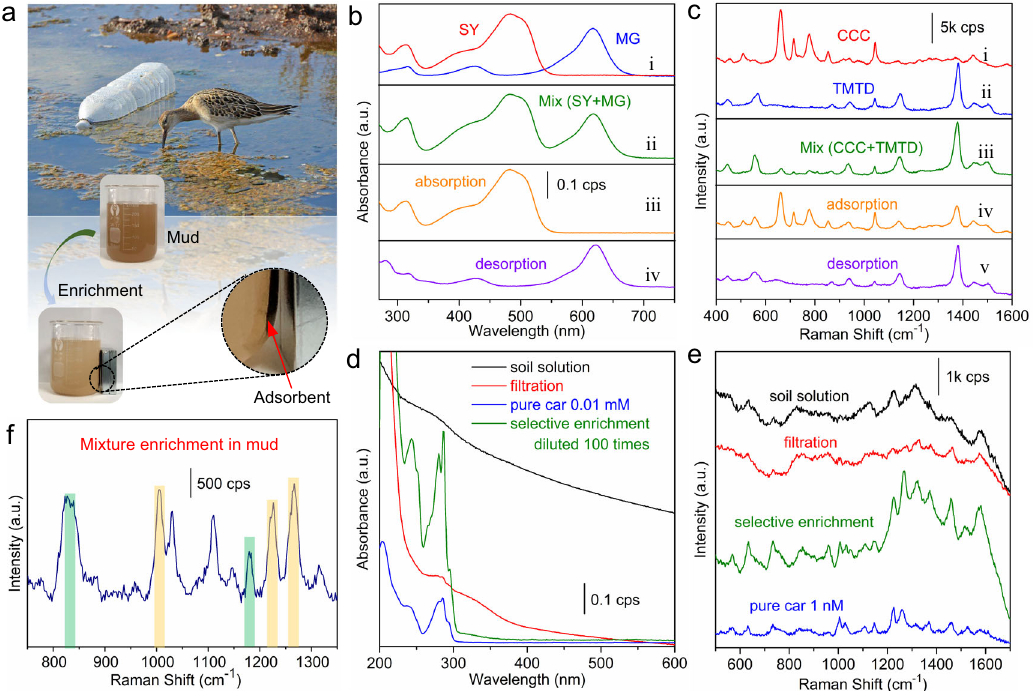
Fig. 5 Separation and selective enrichment in complex matrix used this strategy. a Optical photographs about the enrichment process of MN-PCDP in mud water. b UV − Vis spectra of SY ( i , 0.01 mM), MG ( i , 0.01 mM) and SY/MG ( ii , both with 0.01 mM) mixture solution. iii The fi ltration mixture solution after the absorption of MN-PCDP for MG. iv The desorption solution of captured molecules (MG) redispersed in ethanol from the cavity of MN-PCDP adsorbent. c Raman spectra of CCC ( i , 0.1 mM), TMTD ( ii , 1 µ M) and iii CCC (0.1 mM) /TMTD (1 µ M) mixture solution before and after iv absorption,